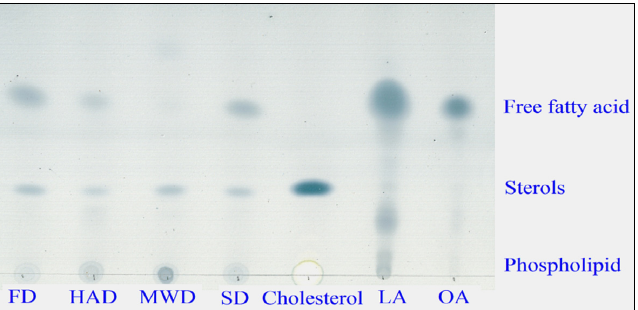
Figure 5. Chromatographic separation of the lipids from mushroom powders and lipid standards: FD—freeze drying; HAD—hot air drying; MWD—microwave drying; SD—sun drying; OA—oleic acid; LA—linoleic acid.